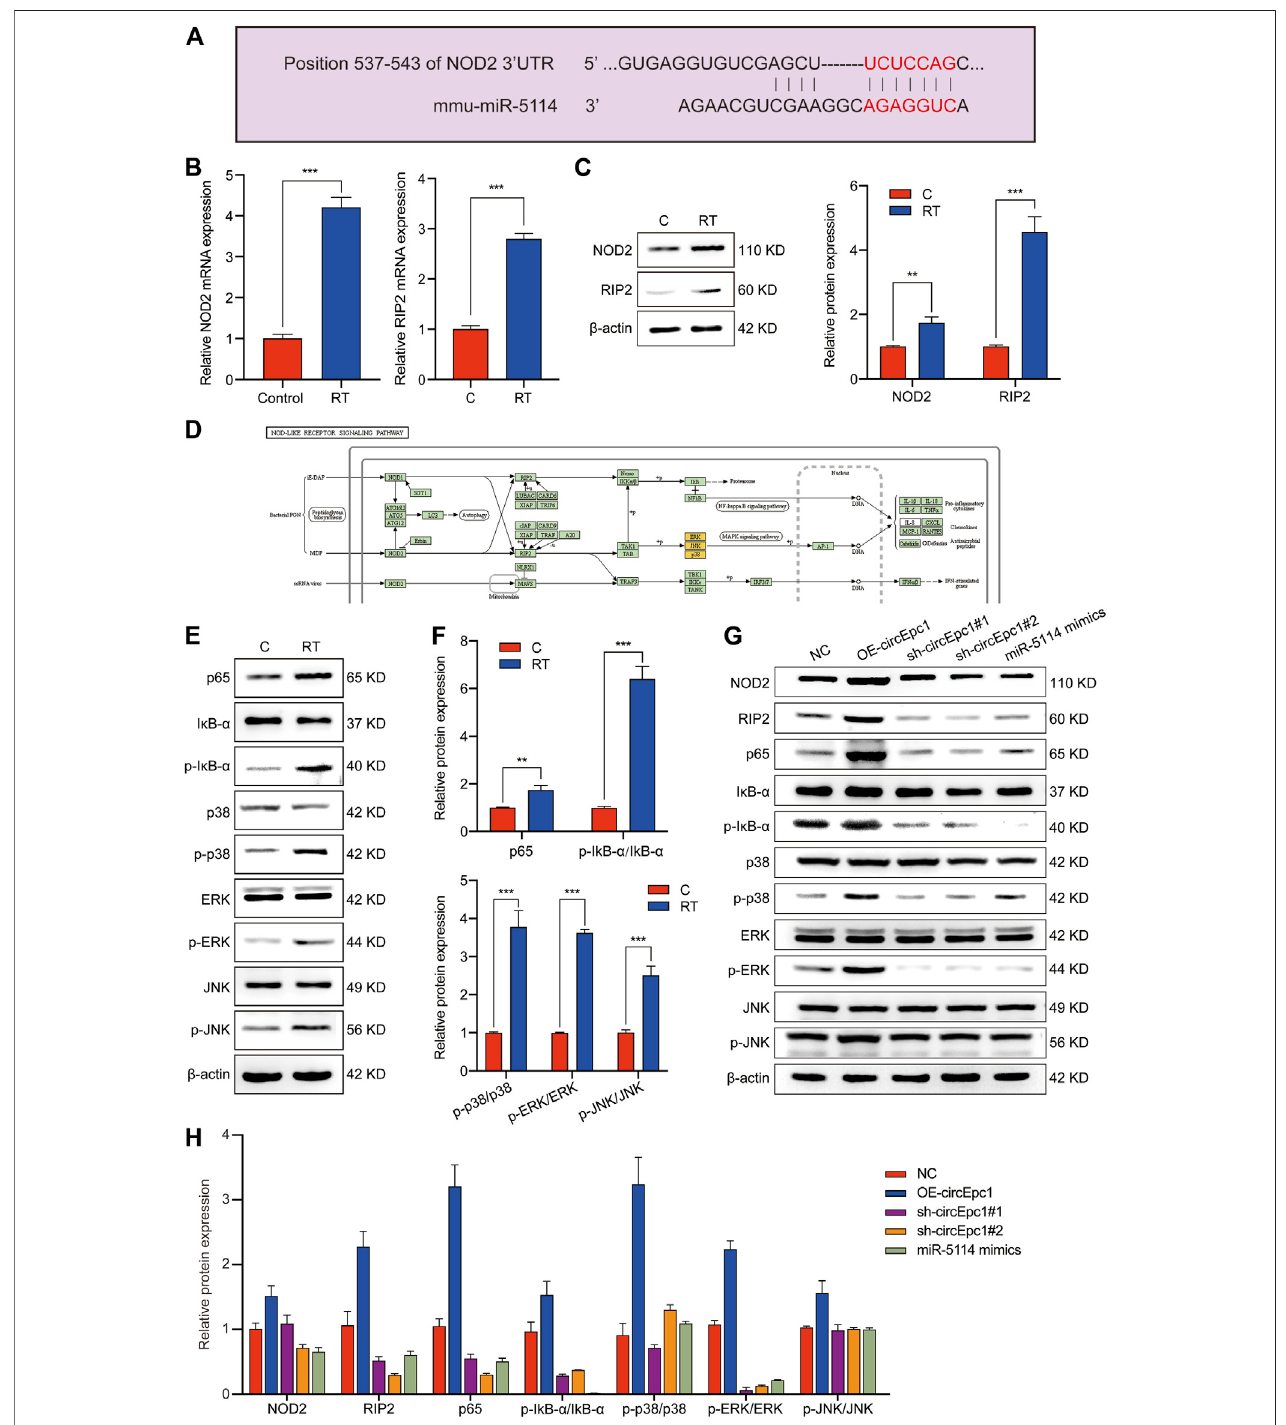
FIGURE5| CircEpc1facilitatesRT-inducedin fl ammationbyrelievingrepressionofmiR-5114forNOD2expressioninRAW264.7cells.( A) ThebindingsitesofmiR- 5114and NOD2werepredicted byTargetScandatabase.( B) ExpressionlevelofNOD2and RIP2 incontroland RT-treated RAW264.7 cells.( C) Theprotein expression level of NOD2 and RIP2 in control and RT-treated RAW264.7 cells. (D) NOD-Like Receptor signaling pathway. ( E , F) Western blot assays were used to evaluate the activationofMAPKand NF- κ Bsignalingpathways inRAW264.7 cellsinducedbyRT.( G,H) Western blotassayswereusedtoevaluate theeffects ofcircEpc1and miR-5114on NOD2, RIP2,MAPK and NF- κ Bsignaling pathwaysin RT-induced in fl ammation. Theintensity ofbands were scanned and measured byImageJ software, and were summarized as bar graphs. Data represent the mean ± SD from three representative experiments (* p < 0.05, ** p < 0.01, *** p < 0.001).